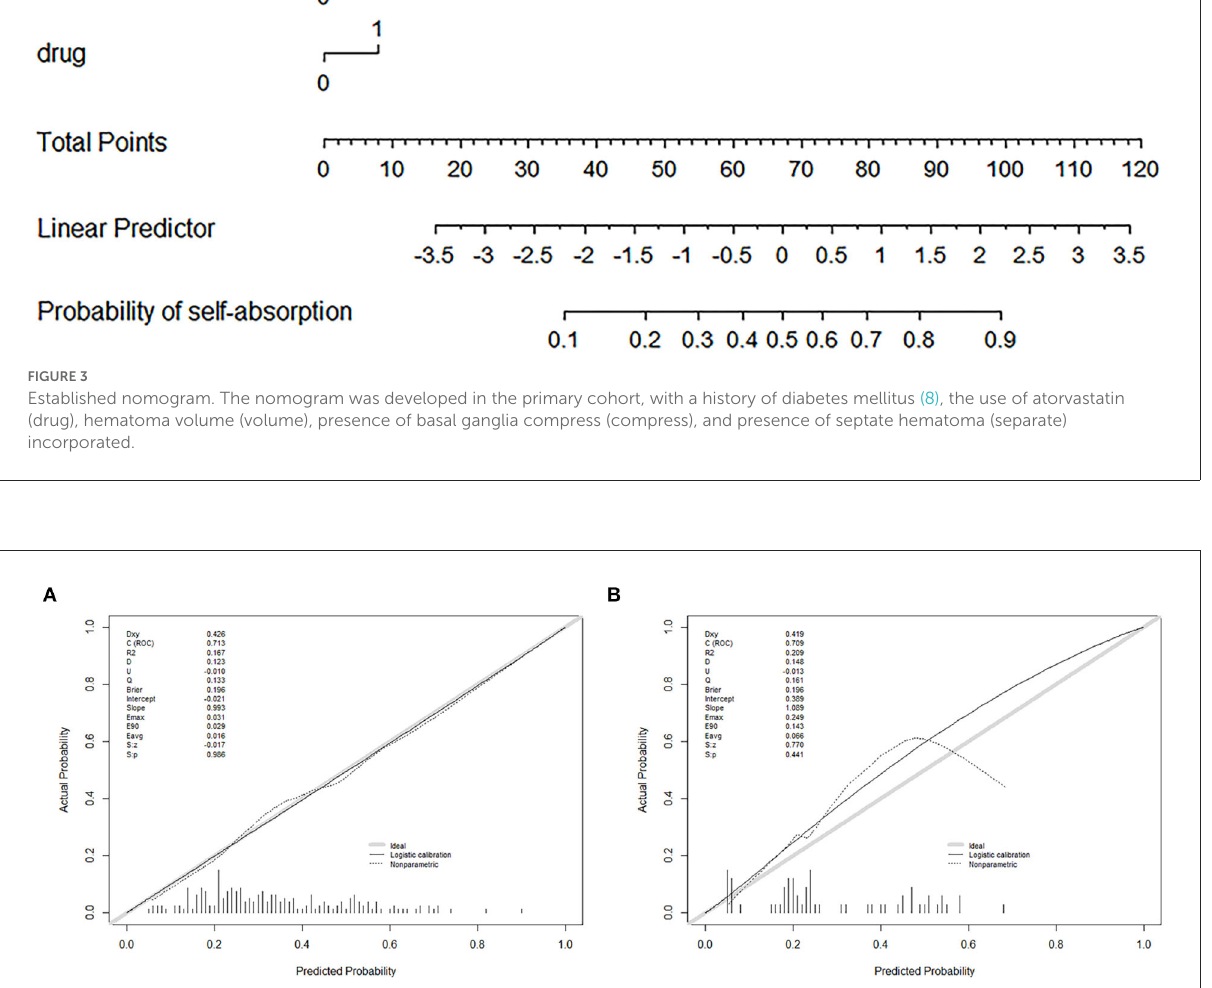
FIGURE4 Calibration curves of the nomogram prediction in each cohort. (A) A calibration curve of the nomogram in the primary cohort. (B) A calibration curve of the nomogram in the validation cohort. Calibration curves depict the calibration of each model in terms of the agreement between the predicted probability of self-absorption and observed outcomes of self-absorption. The y -axis represents the actual self-absorption rate. The x -axis represents the predicted self-absorption probability. The diagonal gray solid line represents a perfect prediction by an ideal model. The thin black solid line represents the performance of the nomogram, of which a closer fit to the diagonal solid line represents a better